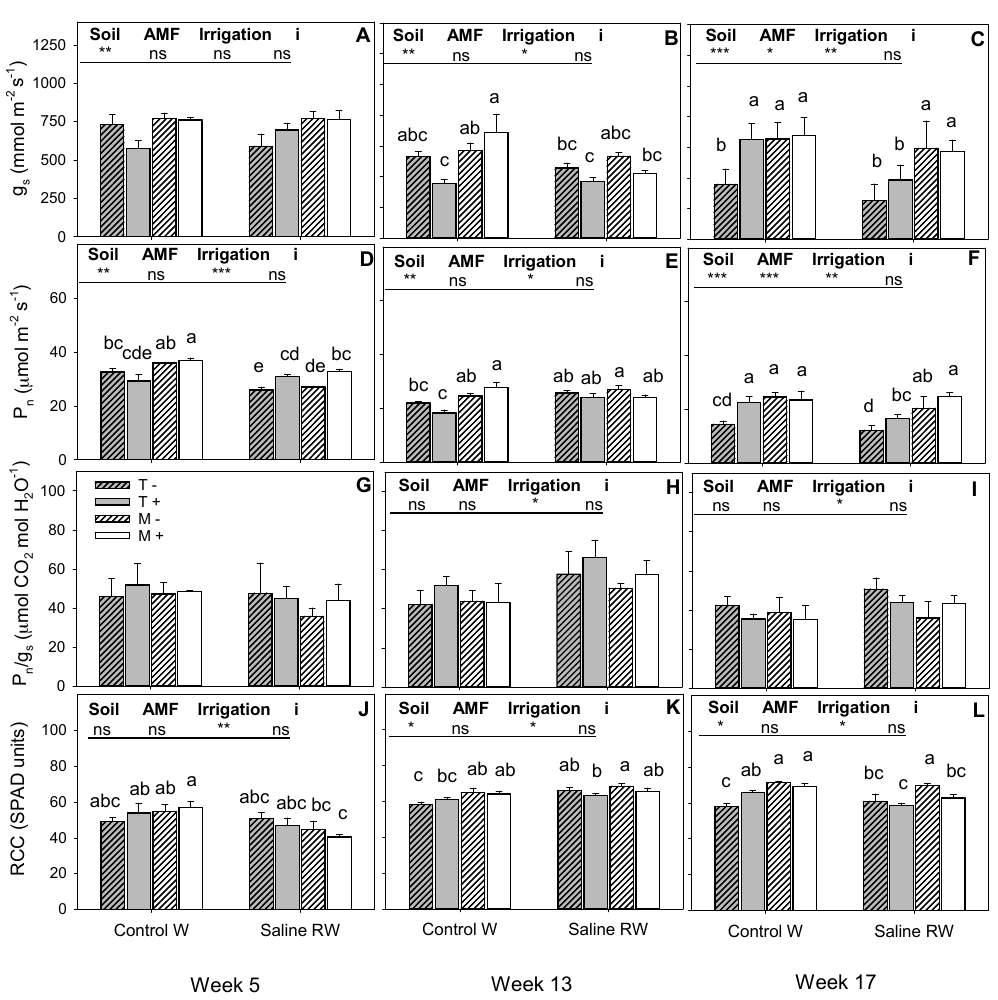
Figure 4. Stomatal conductance (gs) ( A , B , C ), net photosynthetic rate (Pn) ( D , E , F ), intrinsic water use e ffi ciency (P n / g s ) ( G , H , I ) and relative chlorophyll content (RCC) ( J , K , L ) in plants irrigated with control water (Control W) and saline reclaimed wastewater (Saline RW) growing in traditional soil (T) or mixed substrate (M) without ( − ) and with AMF ( + ) inoculation, at weeks 5, 13 and 17. Results of one way and three-way ANOVA tests in these parameters, for independent variables (soil, AMF and irrigation) and their interaction (i). Di ff erent lowercase letters indicate significant di ff erences between treatments according to Duncan test at p ≤ 0.05. * p < 0.05, ** p < 0.01 and *** p < 0.05. p > 0.05 non-significant di ff erences are indicated by ”ns”.